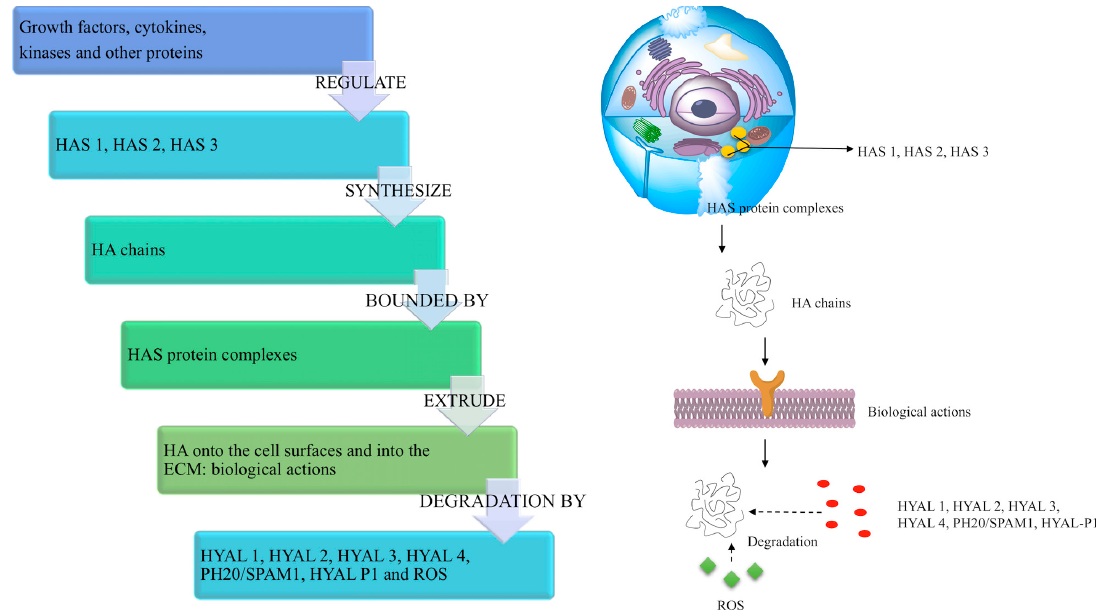
Figure 3. Schematic diagram showing HA key steps from its synthesis to its degradation.